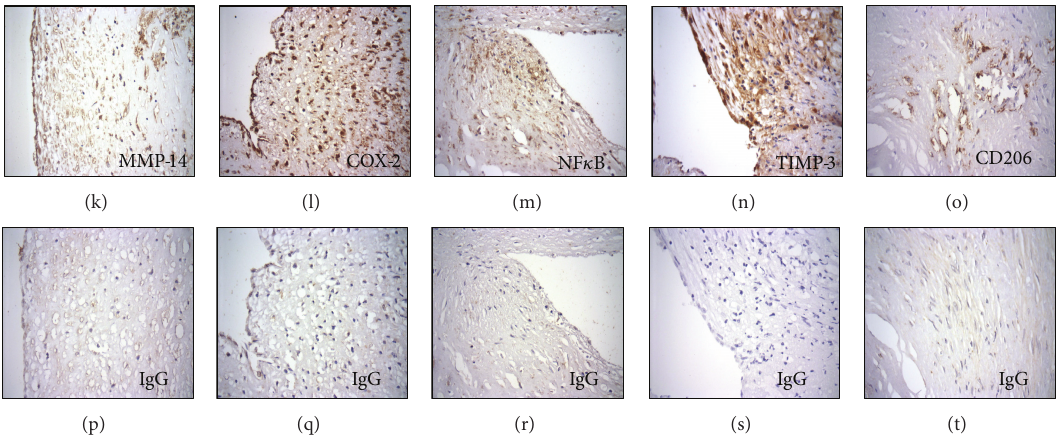
Figure 2: ((a)–(f)) Immunolocalisation of macrophages (CD68), MMP-14, and TIMP-3 in human atheromatous ((a)–(c)) and fibrous- atheromatous ((d)-(e)) carotid plaques. Panels (b)-(c) and (e)-(f) are higher magnification fields of boxes depicted in panels (a) and (d), respectively. SR denotes shoulder region, NC denotes necrotic core, and FC denotes fibrous cap. ((g)–(j)) Immunohistochemistry of atheromatous carotid plaques demonstrating MMP- 14 hi TIMP- 3 lo ((g) and (h), serial sections) and MMP- 14 lo TIMP- 3 hi ((i) and (j), serial sections) foam-cell macrophage regions. Arrows indicate same cells in adjoining serial sections. ((k)–(t)) Immunohistochemical staining (brown product colour) of carotid plaque sections for (k) MMP-14, (l) COX-2, (m) NF 𝜅 B, (n) TIMP-3, and (o) CD206 and their relevant control IgG on serial sections ((p)–(t),